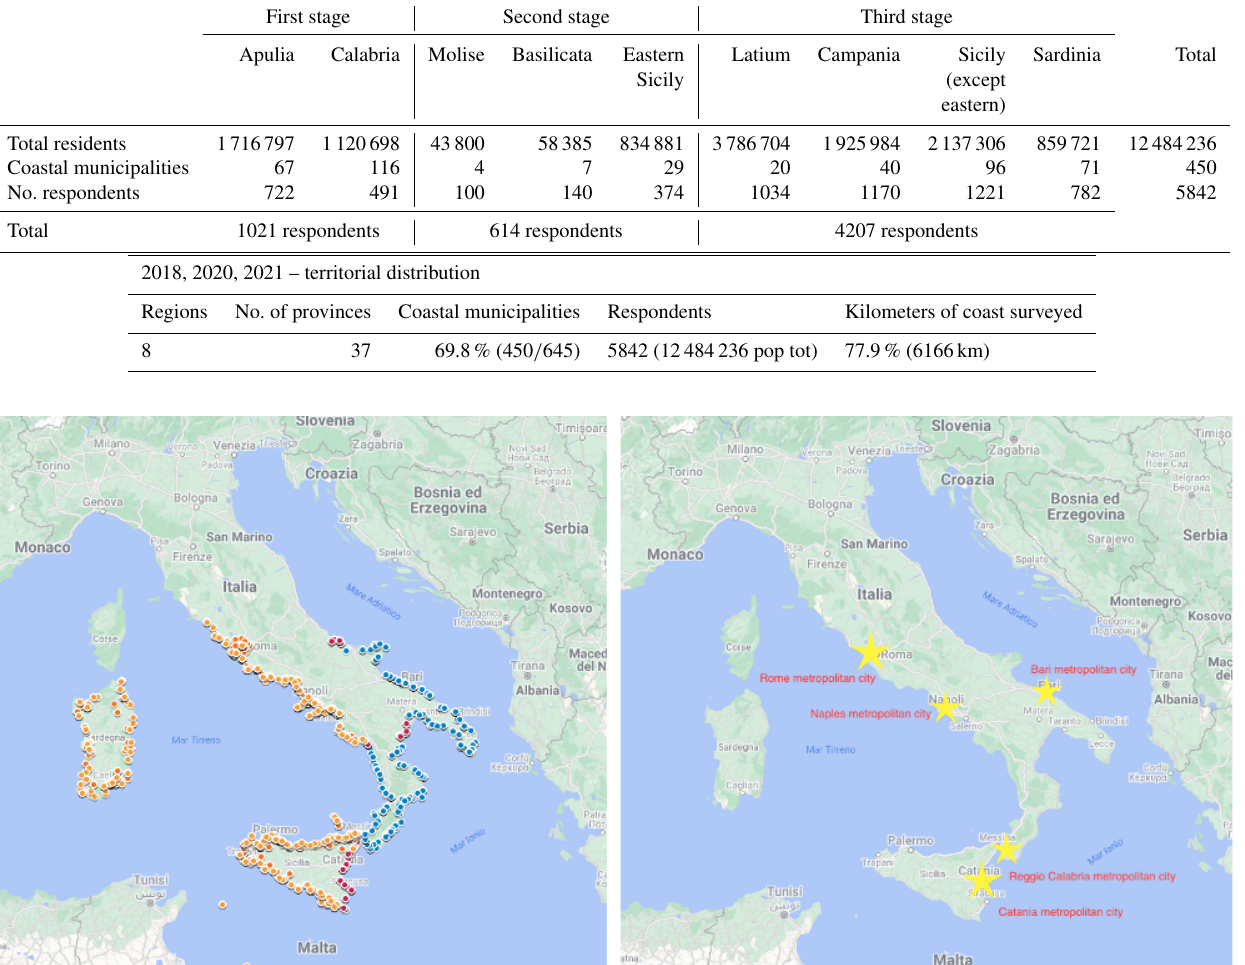
Table 1. Sample distribution in the three survey stages.